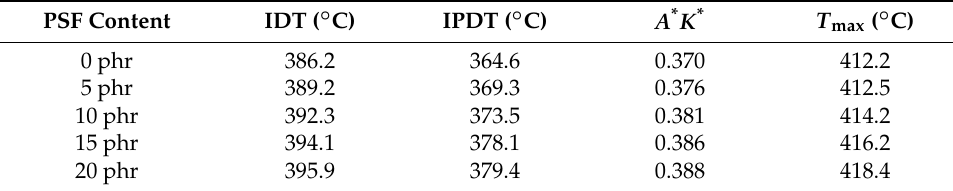
Table 2. Thermal stability parameters of polysulfone (PSF)/epoxy